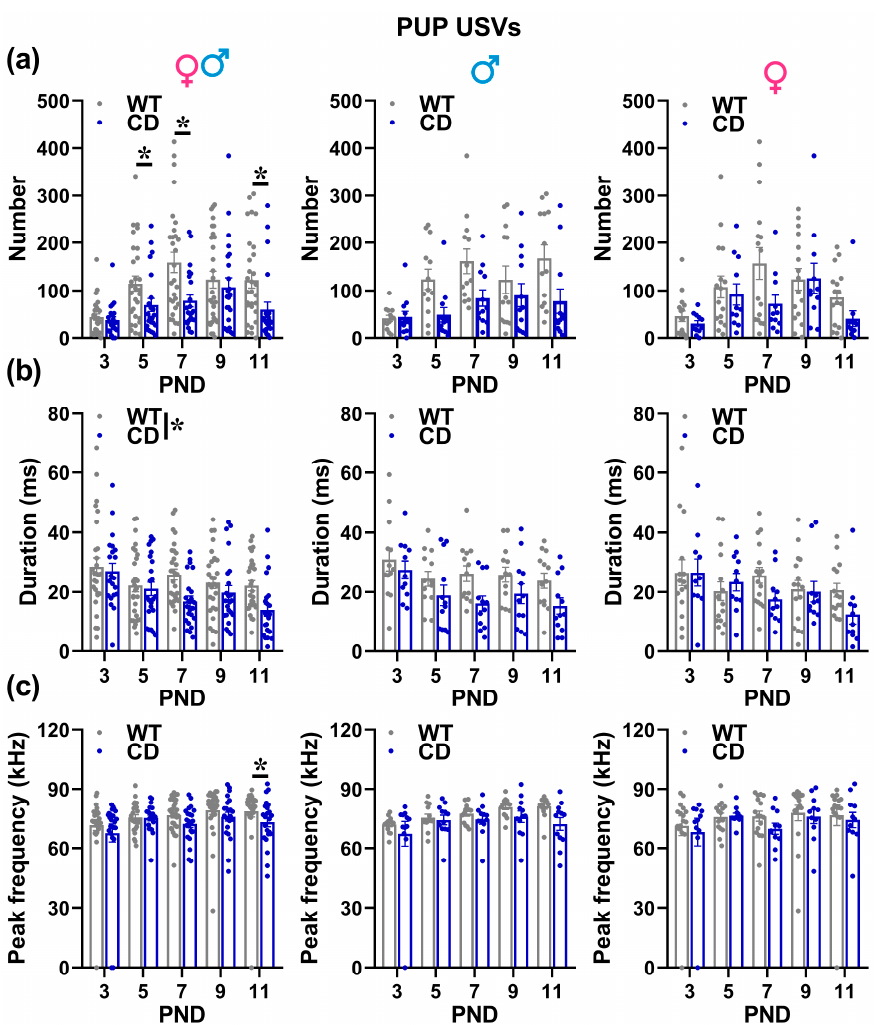
Figure 3. Ultrasonic vocalizations (USVs) emitted by mouse pups. USVs were recorded by isolated pups during 3-min sessions and analyzed in their number ( a ), mean duration ( b ) and mean peak frequency ( c ) using Avisoft software, as described in the text. * = p < 0.05. Genotype differences emerged from ANOVA either from a main significant genotype effect ( b ) or from a significant interaction genotype × testing day followed by pairwise comparisons ( a , c ). Statistical analyses were not conducted separately in males and females since no significant interaction with sex emerged. N = 25 males (13 WT, 12 CD) and 27 females (16 WT, 11 CD).